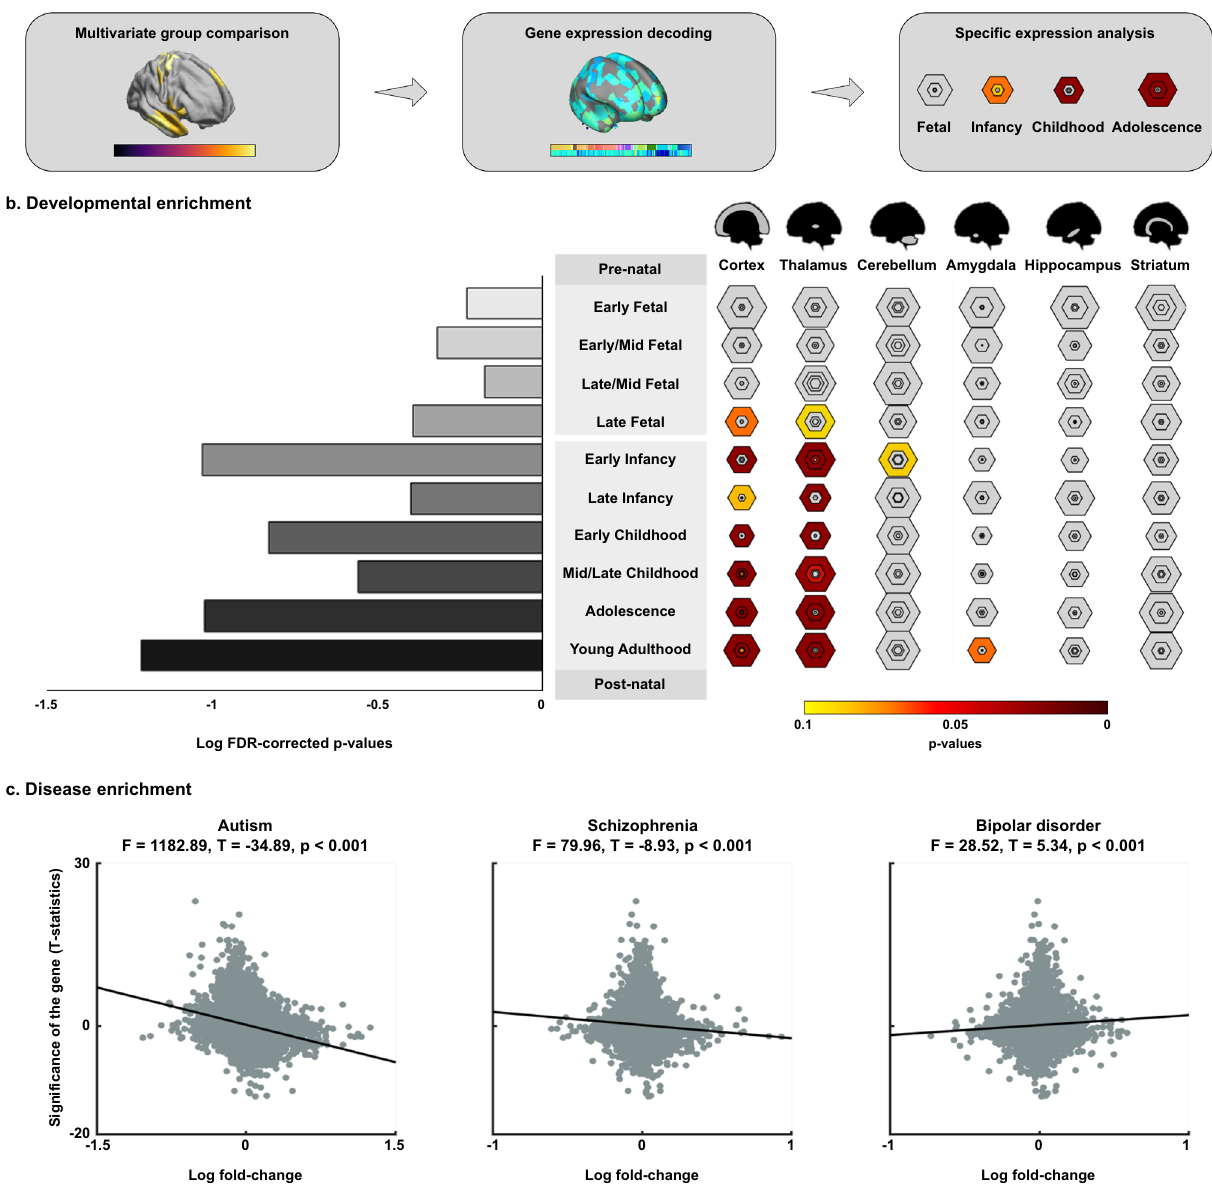
Fig. 3 Transcriptomic analysis to identify gene expression patterns. a Schema to relate multivariate manifold distortions with gene expression patterns and to perform a cell-type-speci fi c gene expression analysis. b Developmental enrichment, showing strong associations with cortex and thalamus during early childhood and adolescence, as well as early infancy and young adulthood. The size of hexagon rings represents the proportion of genes speci fi cally expressed in a particular tissue at a particular developmental stage. Varying stringencies for enrichment with respect to speci fi city index threshold (pSI) are represented by the size of hexagons going from least speci fi c (outer hexagons) to most speci fi c (center hexagons) (pSI = 0.05, 0.01, 0.001, and 0.0001, respectively) 53 . Colors represent the false discovery rate (FDR)-corrected p-values. The bar plot on the left represents the log-transformed FDR-corrected p -values, averaged across all brain structures. c Disease enrichment analysis for associating gene expressions with disease effects of autism, schizophrenia, and bipolar disorder. Source data are provided as a Source Data fi